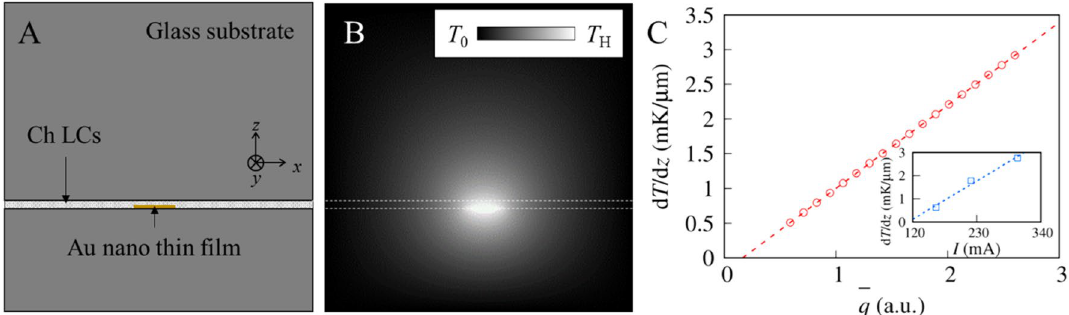
Figure 6. Numerical analysis of the upward micro-temperature gradient generated from Au thin-film electrodes. ( a ) A schematic cross section of the calculation area, which corresponds to the α-α ′ cross section in Fig. 1( a1 ). The Ch-LCs are sandwiched between glass substrates. The temperature at far distances from the Au thin-film electrode was maintained at T 0 . ( b ) The temperature distribution obtained by numerical analysis with q = 0.5. Ch-LCs occupy the area between the white dashed lines. ( c ) q -dependence of the temperature gradient at D = 100 µm. We normalized ˆ q as q = ˆ q / ˆ q ( ∇ T = 1mK / µ m ) . The dashed line shows the fit of the numerical results using a linear function. The inset displays the I dependence of the experimental temperature